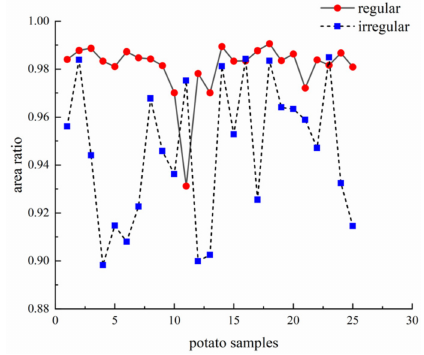
Figure 9. Area ratio of